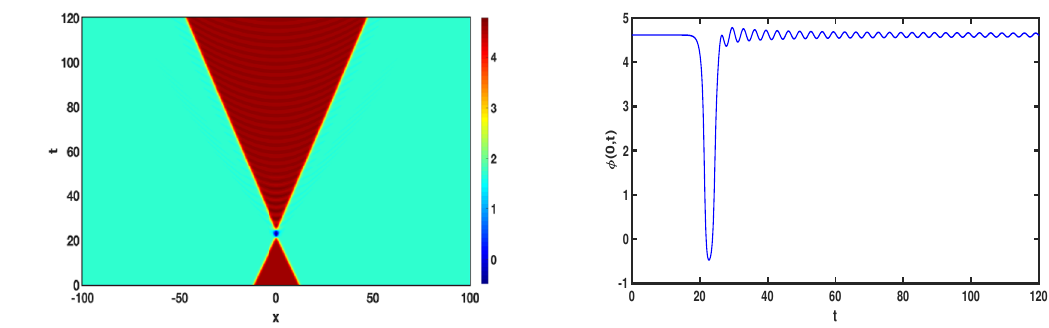
dA/dt A 3 from Manton- | | ∝